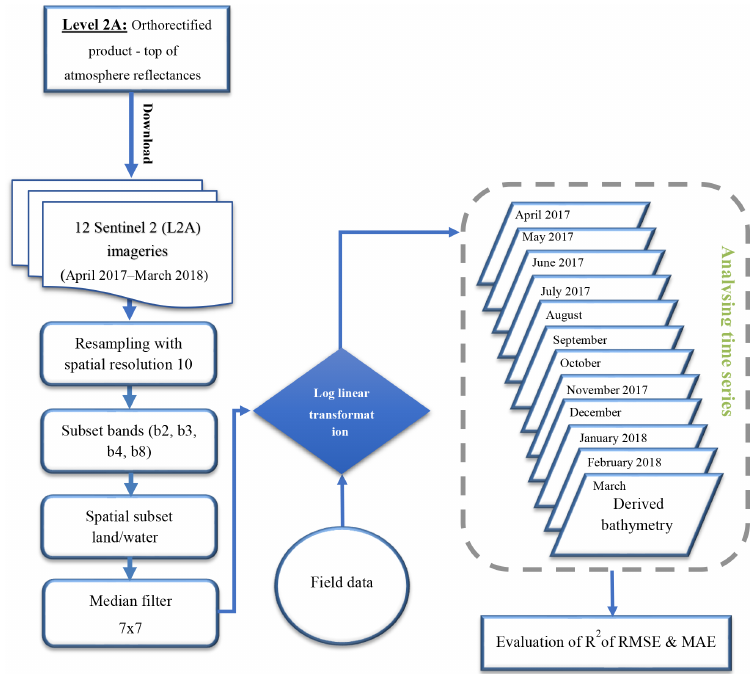
Figure 3. Workflow processing steps detecting bathymetry from Sentinel-2 (L2A) satellites images.